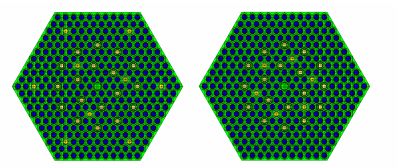
Figure 5. Input of F30G9 (left) and input of F40G6